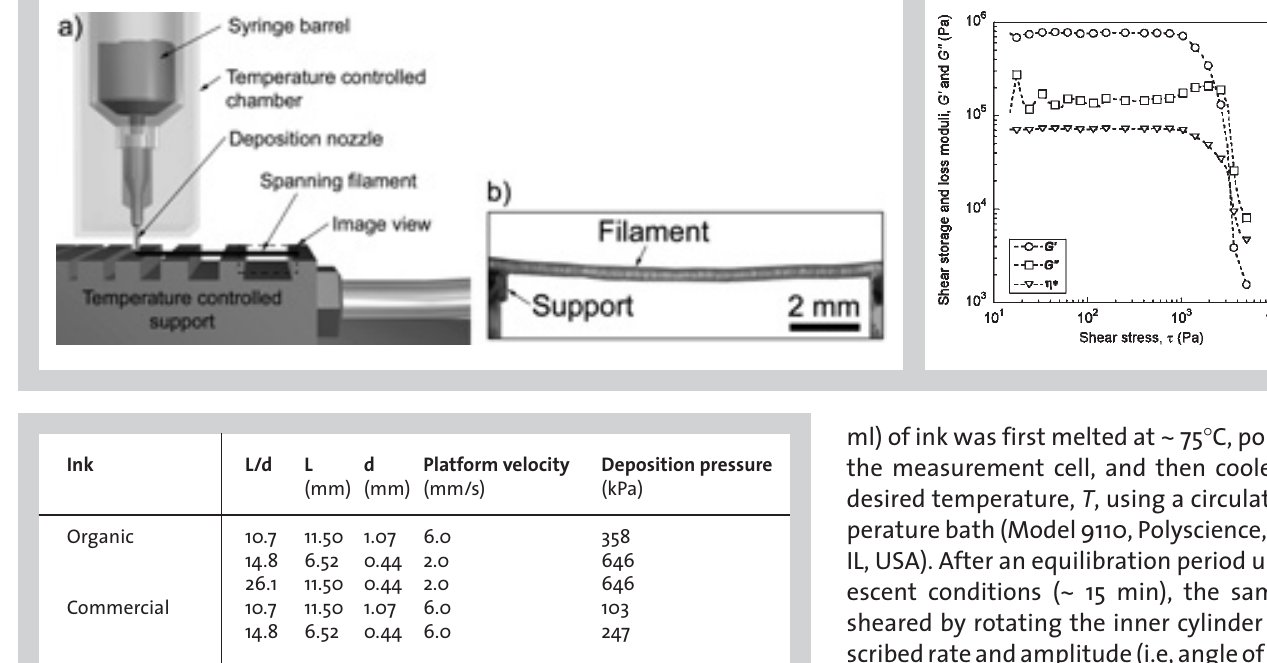
Figure 3 (left): Self-supporting ink filament deformation experiments. a) Experimental setup showing image view. b) Representative optical image for organic ink (L/d = 26.1) at t ~ 25 min and T = 20 ∞ C. Figure 4: Rheological behavior of organic ink as a function of applied shear stress ampli- tude. (T = 25 ∞ C, f = 1 Hz). Table 2: Experimental conditions for self-supporting filament deformation